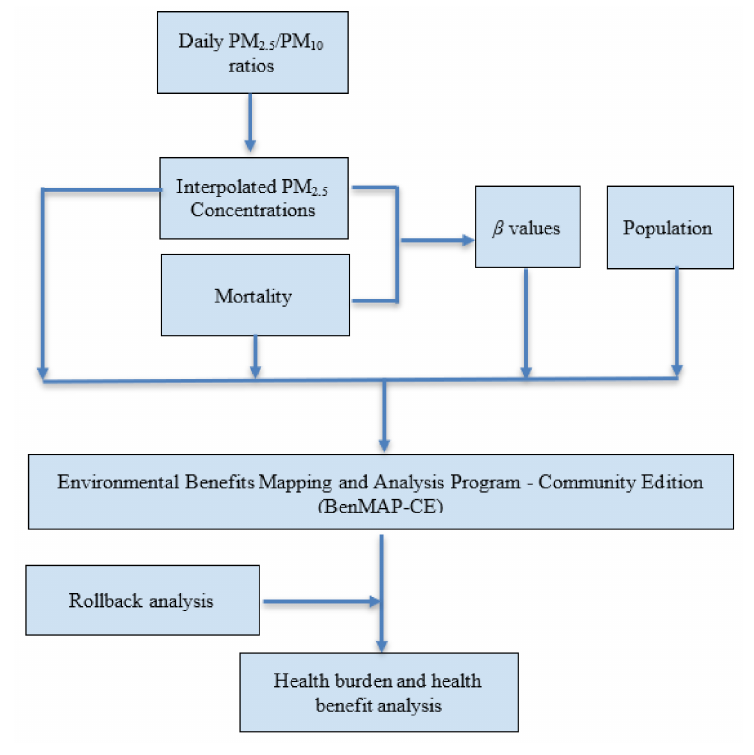
Figure 1. Workflow of the study procedure.